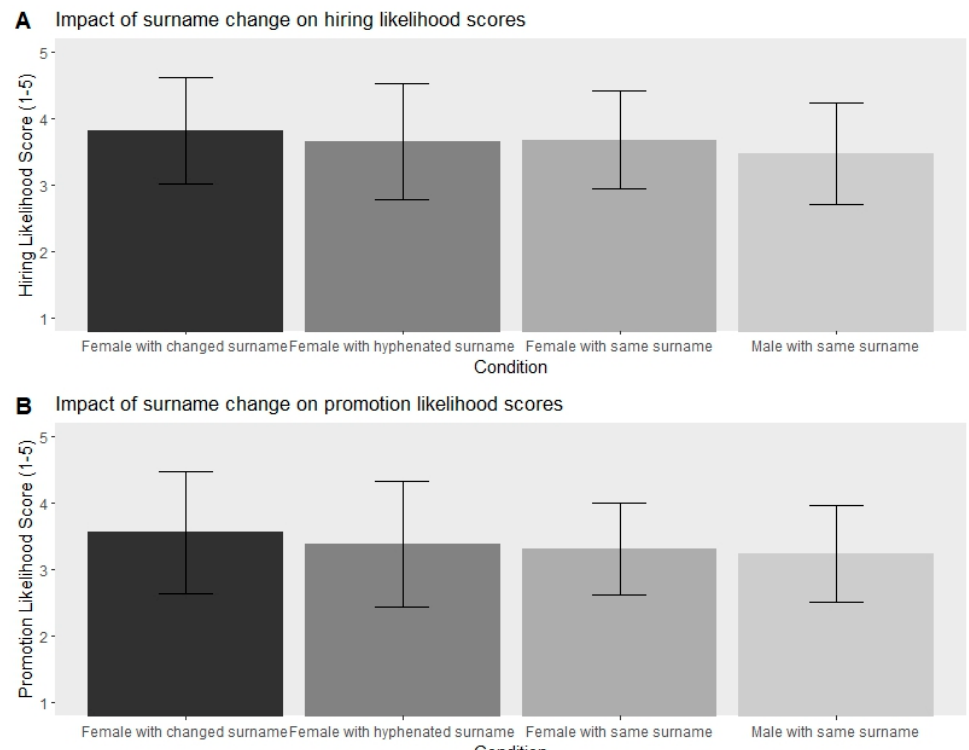
Figure 1. Surname change did not significantly predict hiring (panel A ) or promotion likelihood (panel B ) scores.